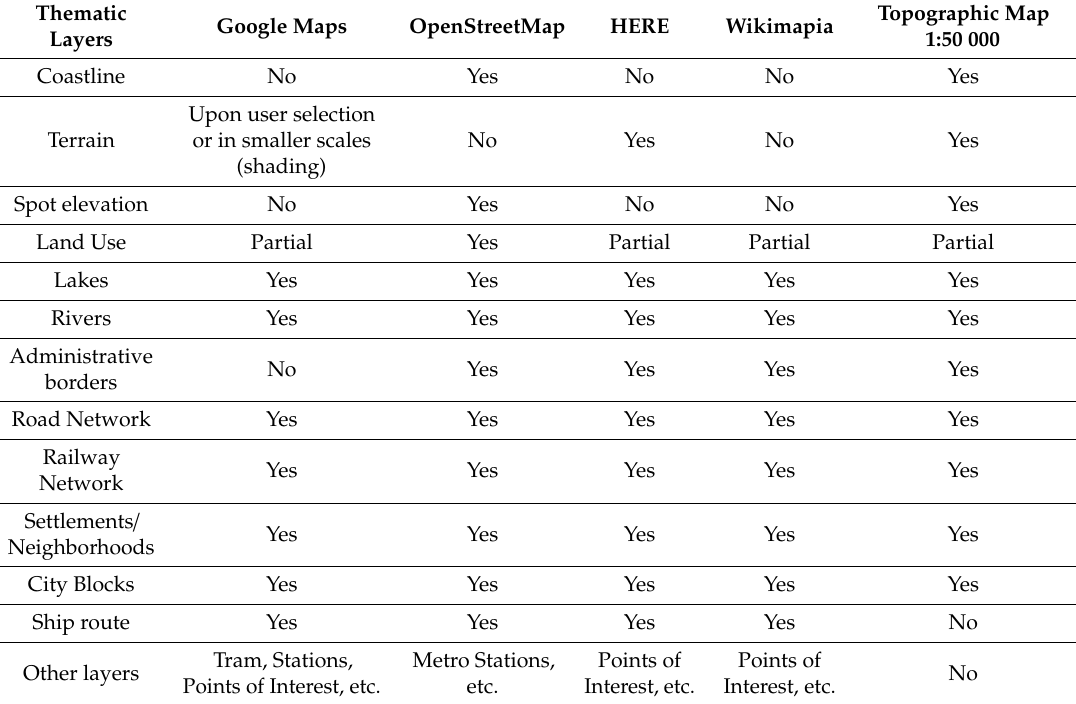
Table 3. Online map services and topographic map